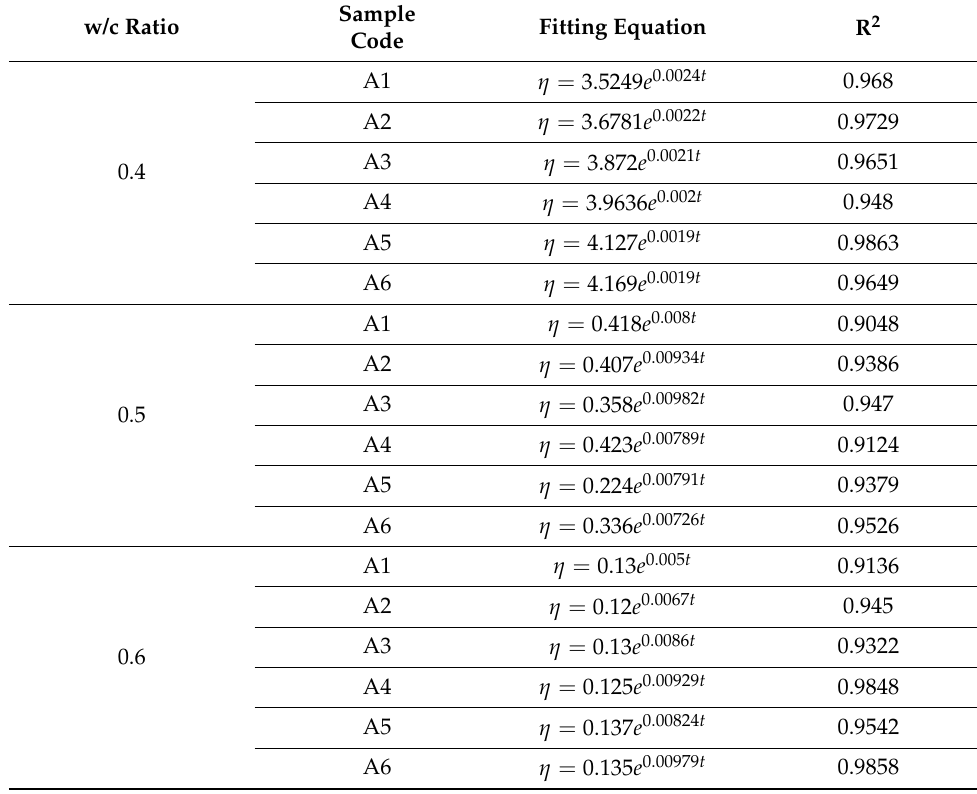
Table 4. Plastic viscosity–time equations of cement paste containing